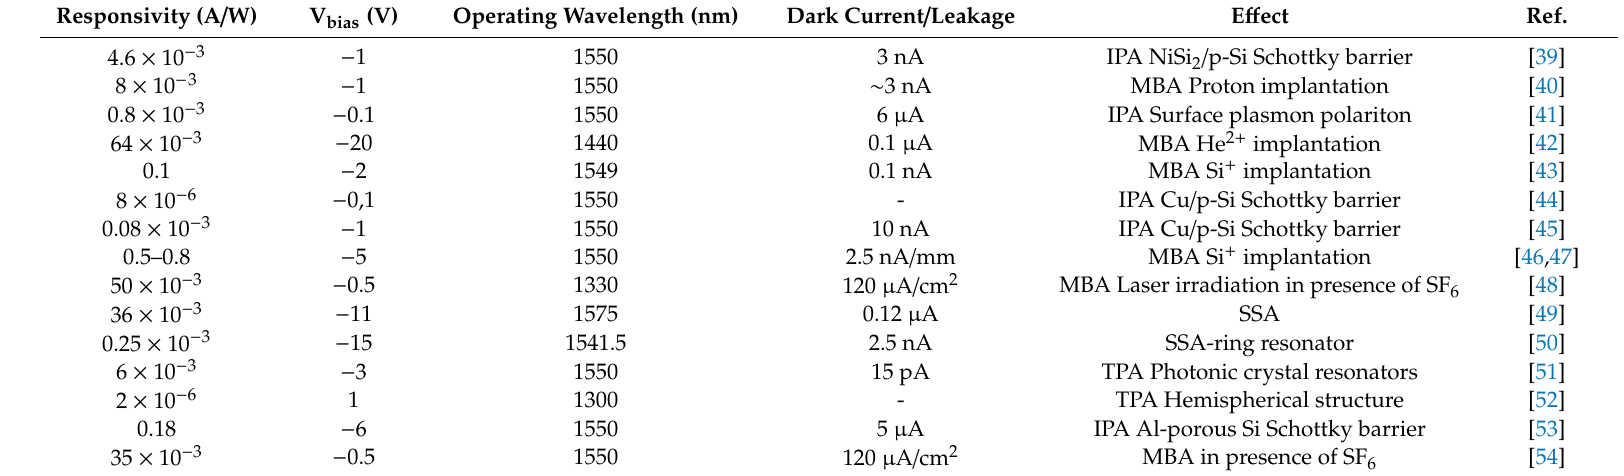
Table 2. Some physical and optical properties at room temperature of narrow gap